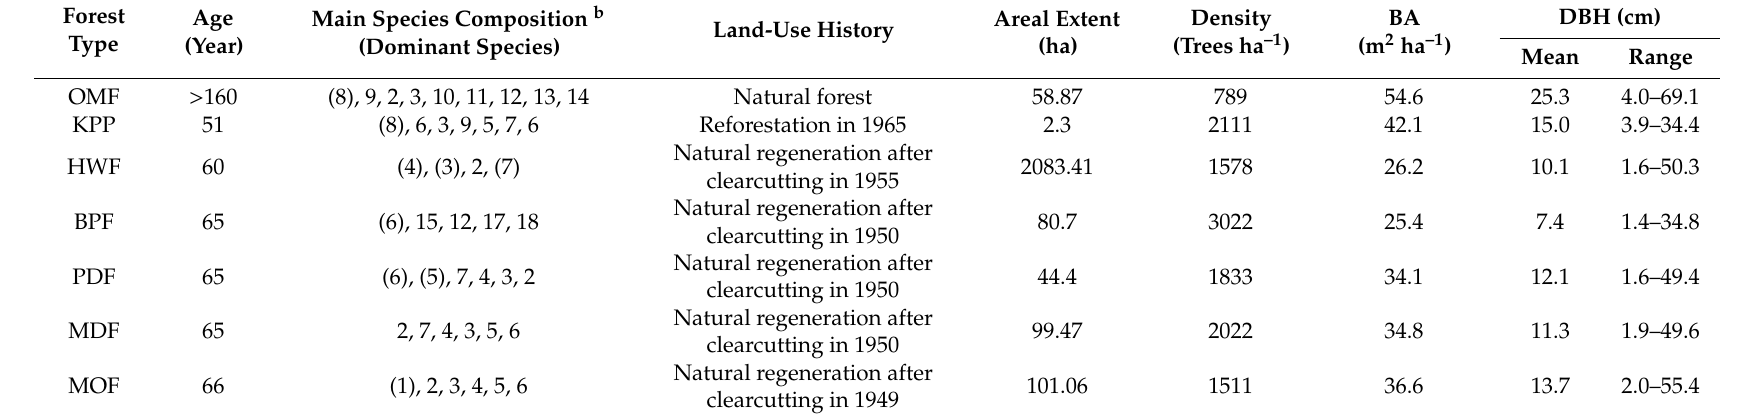
Table 1. Characteristics of stands from which sample trees were harvested a